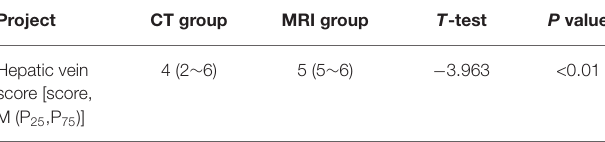
TABLE 3 | Clarity analysis of hepatic vein reconstructed by CT and MRI.